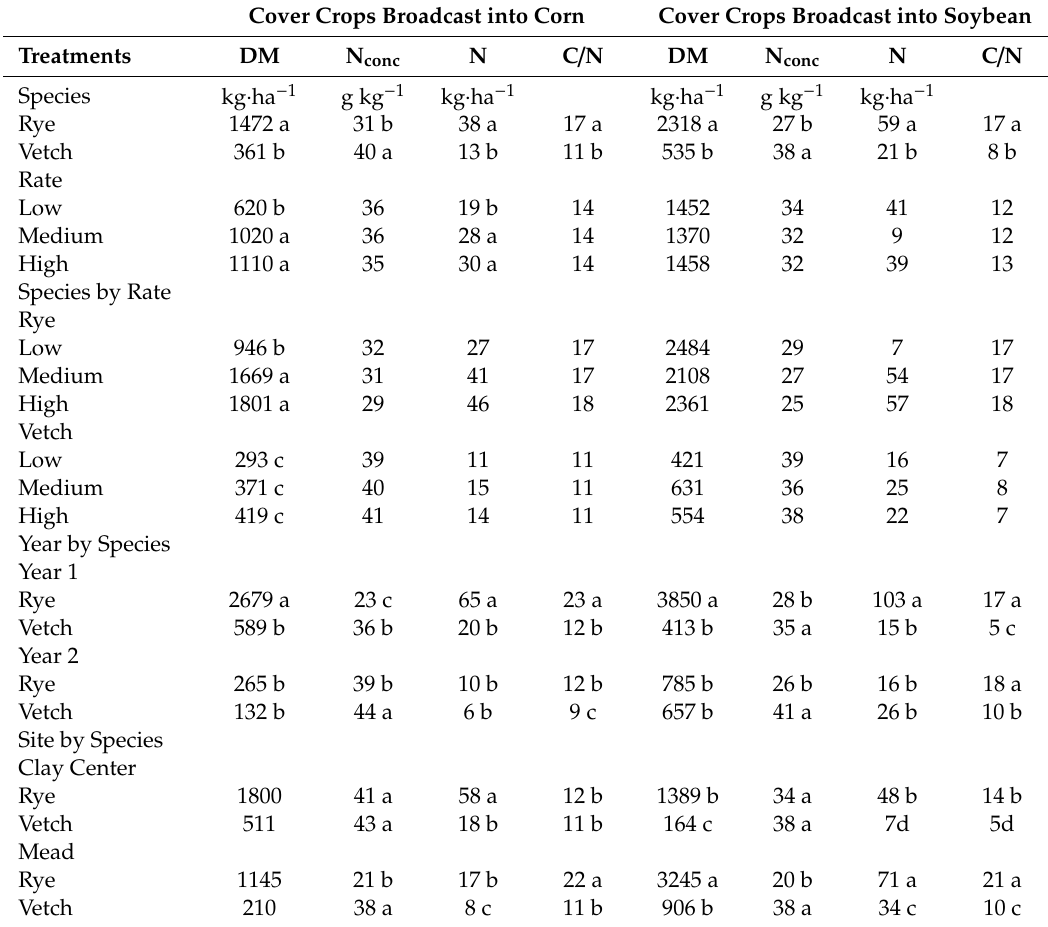
Table 6. Biomass parameter means of cover crops broadcast planted into corn and of cover crops broadcast planted into soybean. The parameters were biomass (DM, in kg · ha − 1 ), biomass N concentration (N conc , in g · kg − 1 ), biomass N uptake (N, in kg · ha − 1 ), and the biomass carbon to nitrogen ratio (C / N). Within a column, means followed by the same letter are not significantly di ff erent from each other at a significance level of α = 0.05. Where rate was significant, it was tested for linear and quadratic e ff ects with results shown in the text. Cover Crops Broadcast into Corn Cover Crops Broadcast into